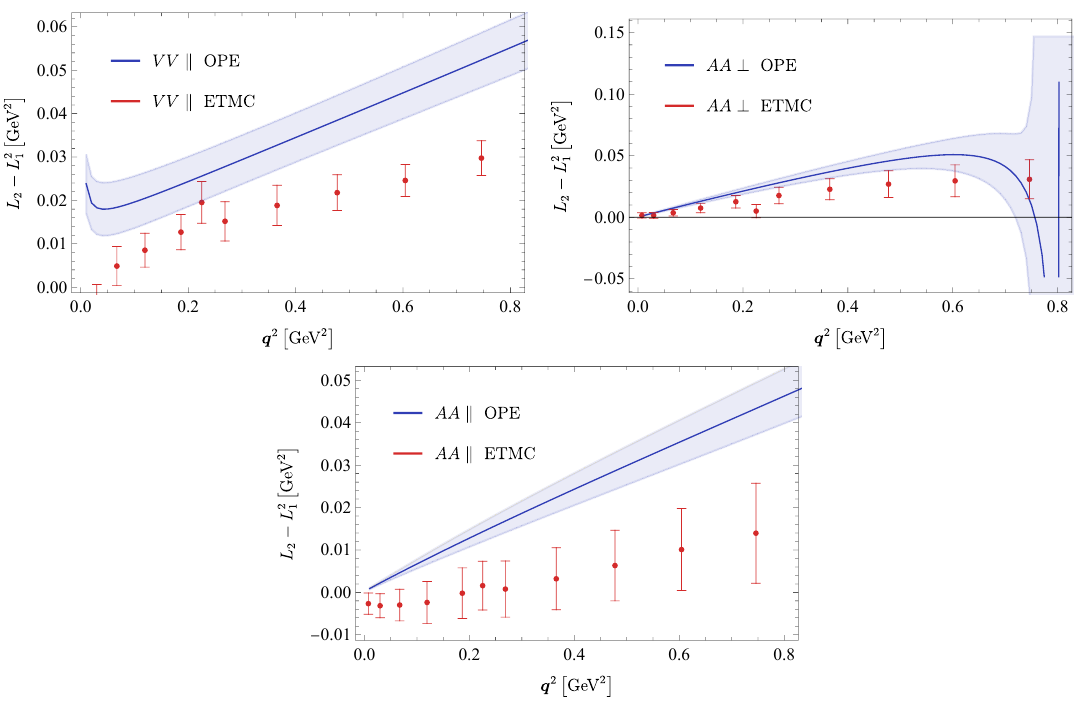
in the various channels. The plots show the 1